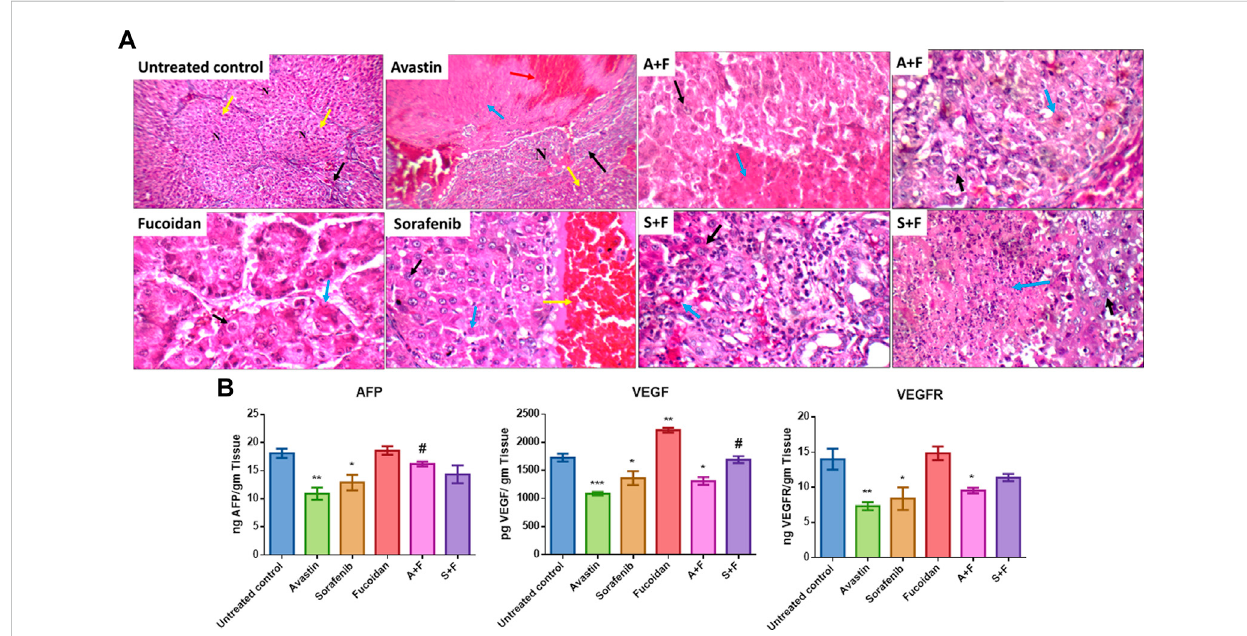
FIGURE 12 (A) LiversectionsofDENtreatedratsaftertreatmentwiththevariousdrugsandtheirrespectivecombination.Positivecontrolshowing fi broticportal tract(blackarrow),withwell-de fi nednodules(yellowarrow,N)(H&EX200).Avastintreatedgroupshowingincompletenodulesandmildmicro-vesicular steatosis (yellow arrow) and large nodule of HCC (black arrow) with marked areas of necrosis (blue arrow) and hemorrhage (red arrow) (H&E X